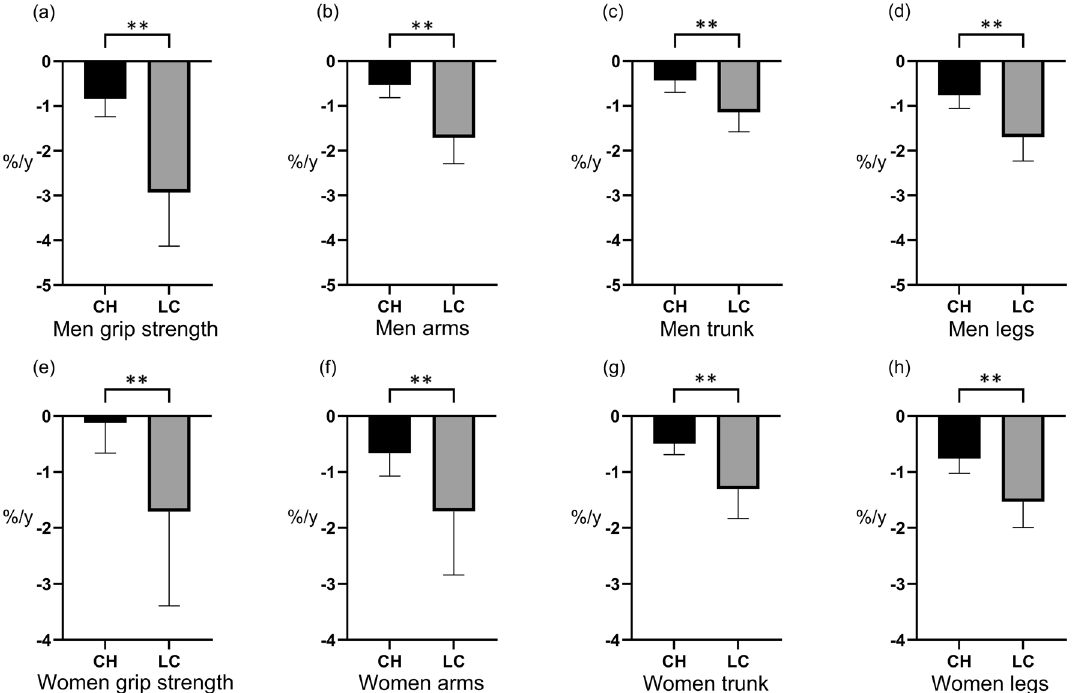
Figure 3. The comparison of the annual rate of change in sarcopenia-relevant factors between patients with chronic hepatitis (CH) and liver cirrhosis (LC). ** P < 0.01. The annual rate of change in ( a ) grip strength and skeletal muscle of ( b ) arms, ( c ) trunk, and ( d ) legs of CH and LC men were − 0.84% vs. − 2.93% ( P < 0.01), − 0.54% vs. − 1.71% ( P < 0.01), − 0.43% vs. − 1.02% ( P < 0.01), and − 0.76% vs. − 1.70% ( P < 0.01), respectively. The annual rate of change in ( e ) grip strength and skeletal muscle of ( f ) arms, ( g ) trunk, and ( h ) legs of CH and LC women were − 0.12% vs. − 1.71% ( P < 0.01), − 0.66% vs. − 1.71% ( P < 0.01), − 0.49% vs. − 1.37% ( P < 0.01), and − 0.76% vs. − 1.54% ( P < 0.01),